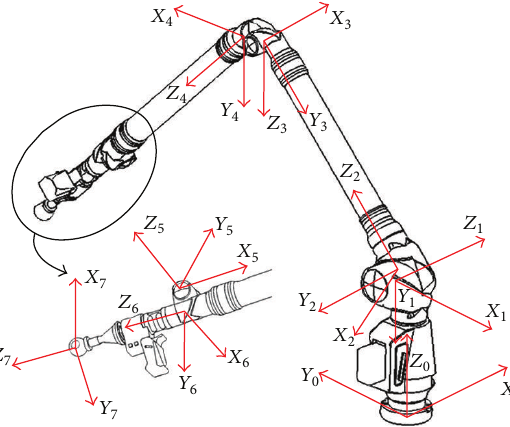
Figure 1: AACMM reference systems.